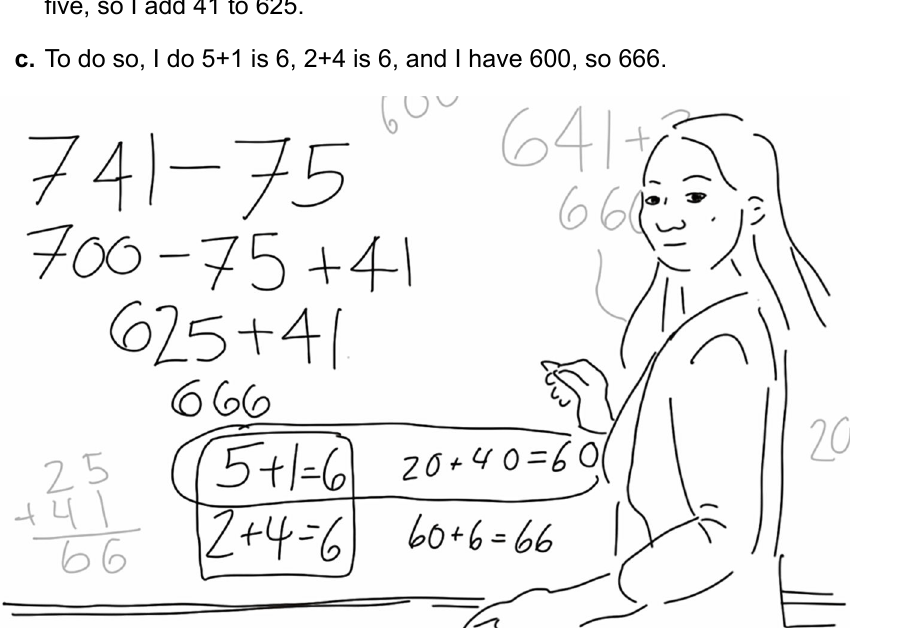
Figure 1. Amy’s presentation of her strategy on the